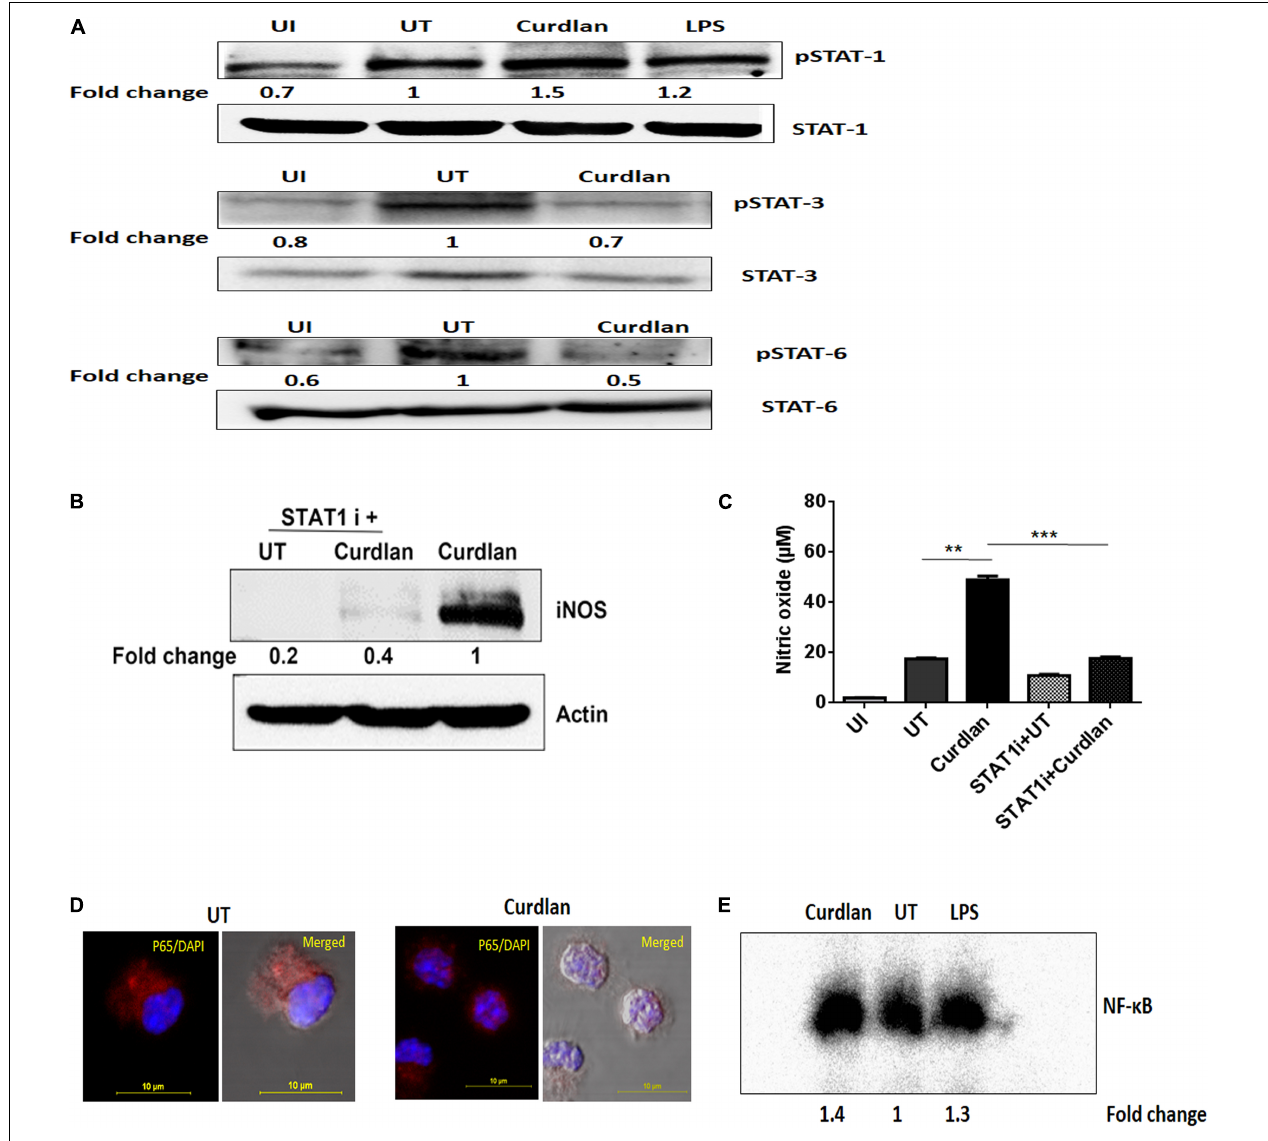
FIGURE 8 | Curdlan activates STAT-1 and NF- κ B in Mtb infected M (cid:56) s. M (cid:56) s were infected with Mtb (MOI of 5) for 4 h followed by treatment with curdlan (50 µ g/ml). (A) After 15–30 min of curdlan stimulation, cell lysates were prepared and analyzed for pSTAT-1, STAT-1, pSTAT-3, STAT-3, pSTAT-6, STAT-6 by western blot. β -actin was used as loading control. (B,C) Infected M (cid:56) s were pretreated with STAT-1 inhibitor (STAT1 i) fludarabine (50 µ M) for 1 h prior to curdlan stimulation for 18 h (to assess iNOS) and 48 h (to examine nitric oxide release), (B) iNOS expression in cell lysates by western blot; blots are representative of two independent experiments. Further, (C) nitric oxide level in cell culture SNs was assessed by Griess assay; data shown as mean ± SD are representative from two independent experiments, each performed in triplicates, ∗∗ p < 0.01, ∗∗∗ p < 0.001. Further, (D,E) Infected M (cid:56) s were stimulated with curdlan for 30 min. Thereafter, (D) nuclear translocation of NF- κ B in M (cid:56) s (p65 subunit) was examined through confocal microscopy; p65 subunit [red]; nucleus stained with DAPI [blue]. (E) Nuclear extract of M (cid:56) s depicts NF- κ B activation by EMSA assay as fold change compared to untreated. Data is representative of two independent experiments. UI, M (cid:56) s not infected with Mtb ; UT, Mtb infected M (cid:56) s; Curdlan, Mtb infected and curdlan stimulated M (cid:56) s; STAT1 i + UT, Mtb infected M (cid:56) s treated with STAT1 inhibitor; STAT1 i + Curdlan, Mtb infected M (cid:56) s treated with STAT1 inhibitor prior to curdlan stimulation; LPS, lipopolysaccharide (2 µ